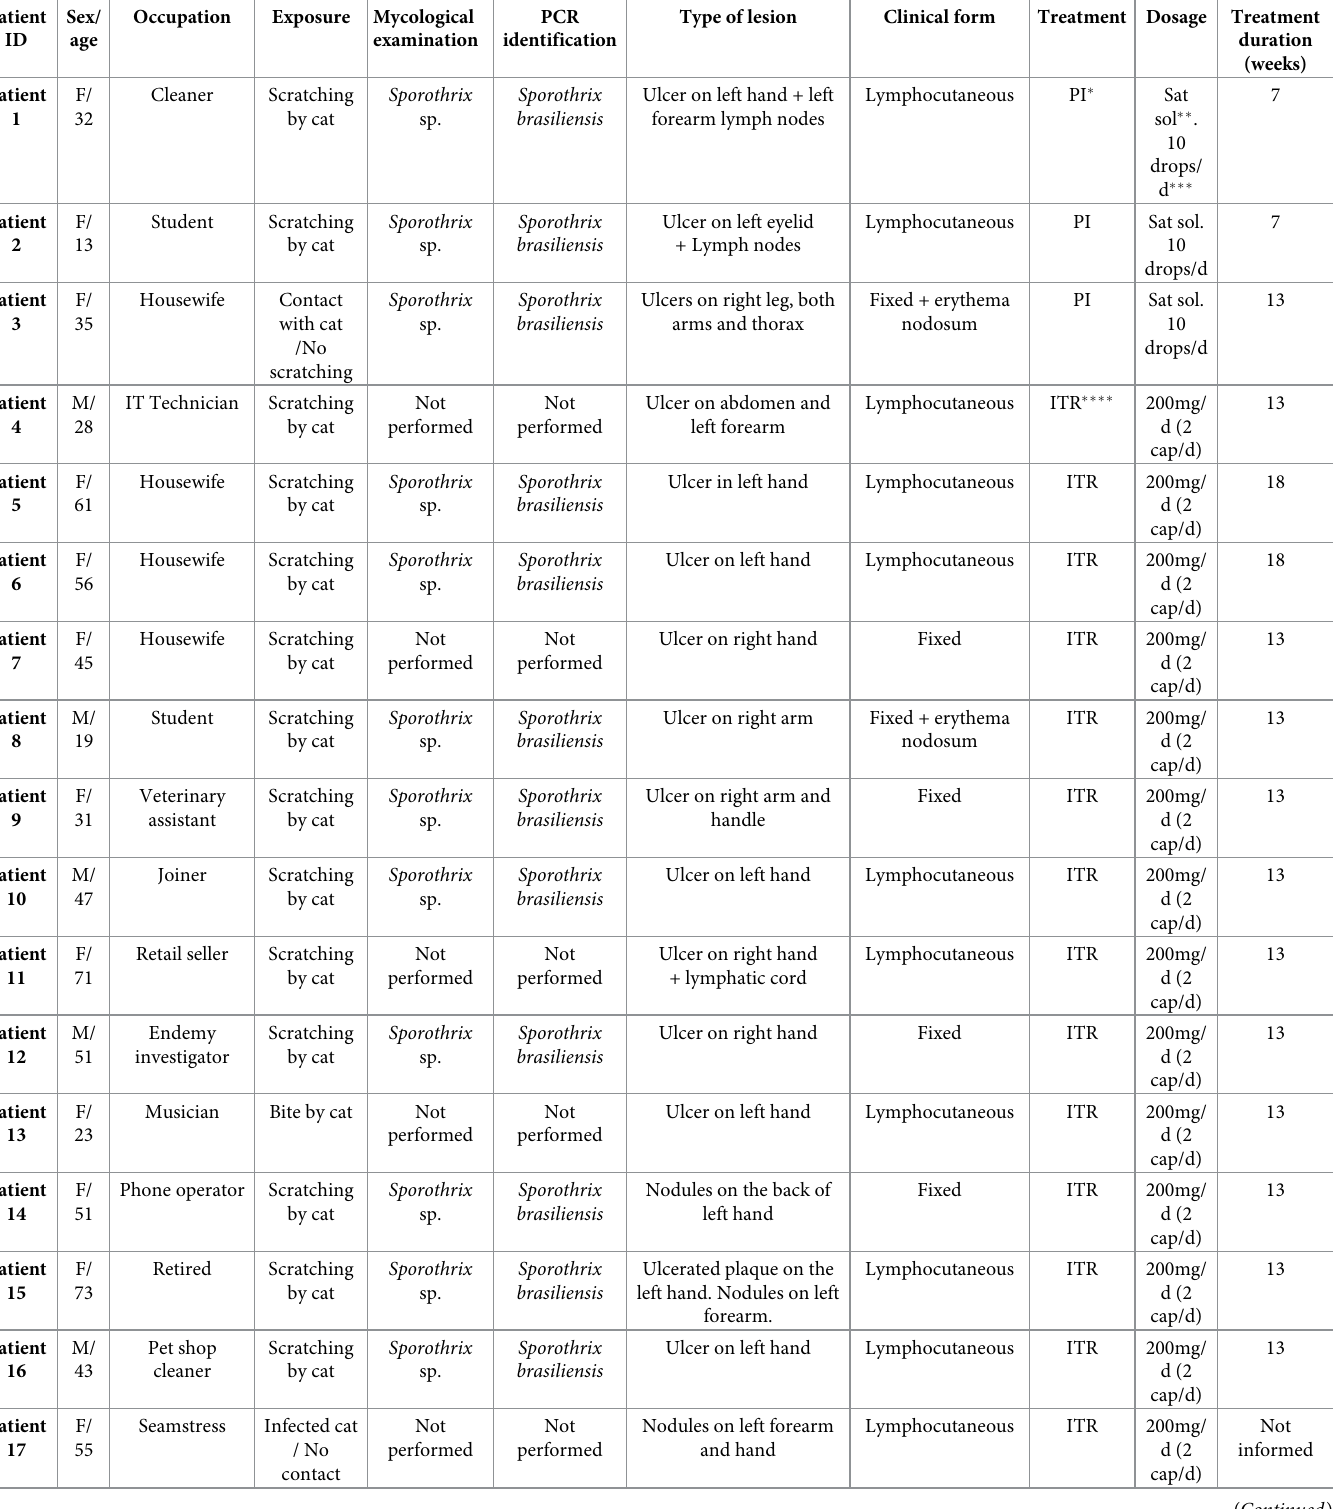
Table 1. Demographic, clinical, mycological, and antifungal treatment data of 122 patients diagnosed with cat-transmitted subcutaneous sporotrichosis from Octo- ber 2016 and December 2019 in Rio Grande do Norte, Northeast Brazil. Patient